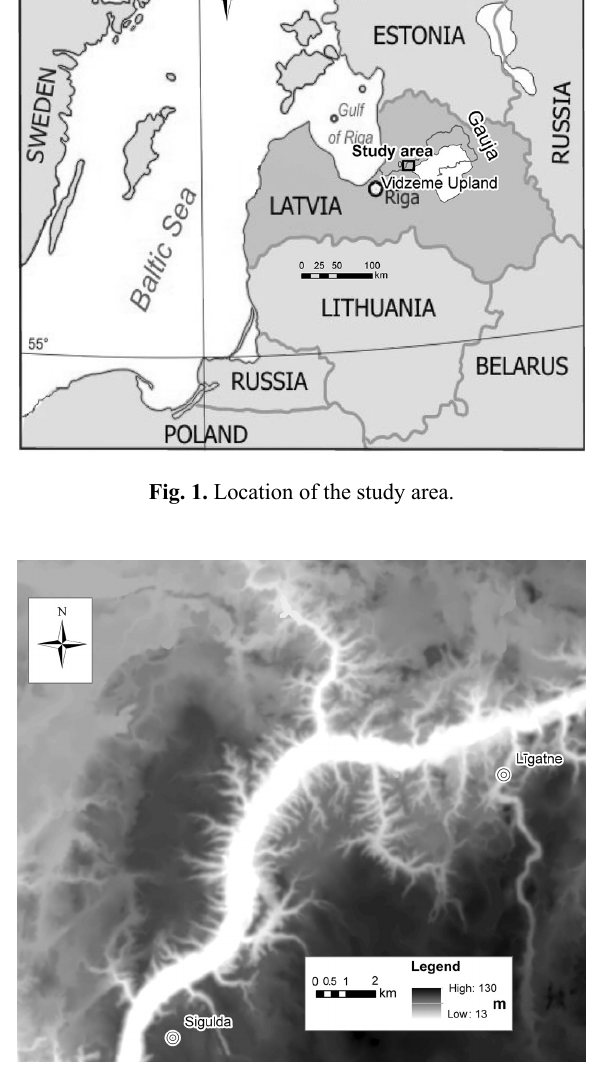
Fig. 2. Digital terrain model of the study area (processed from Jarvis et al.